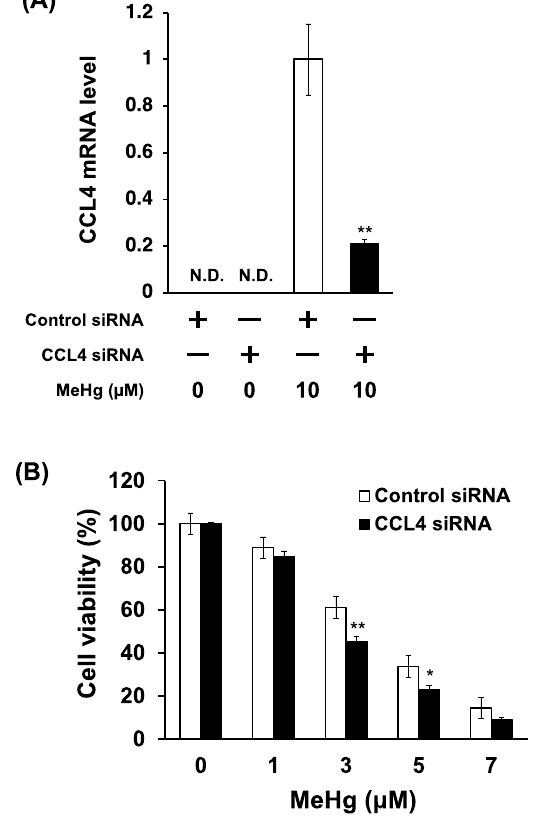
Figure 4. Effects of CCL4 knockdown on the sensitivity of C17.2 cells to methylmercury. C17.2 cells (1 × 10 4 cells/90 µ L) transfected with CCL4 siRNA were seeded into 96-well plates. After incubation for 18 h, transfected cells were treated with indicated concentrations of methylmercuric chloride (MeHg) for 24 h. ( A ) CCL4 mRNA levels were measured by quantitative real-time PCR. ( B ) Cell viability was measured by the alamarBlue ® assay. Data are presented as the mean ± S.D. N.D.: not detected. Statistical significance when compared to corresponding “control siRNA group” at each concentration point: * p < 0.05, ** p < 0.01.